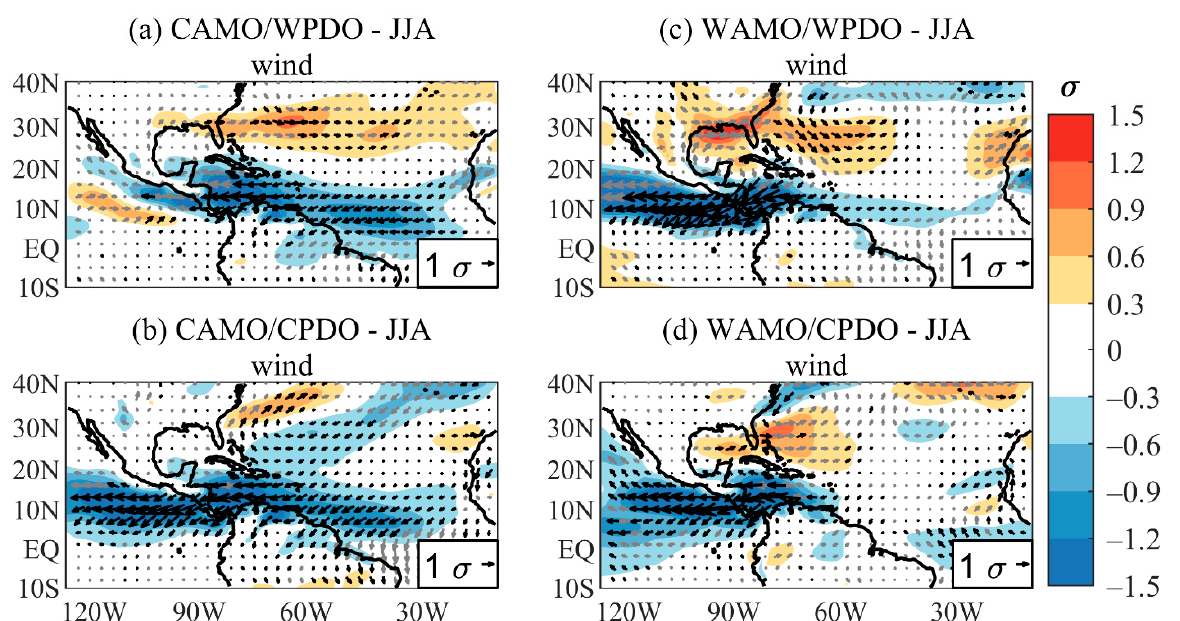
Figure 8. June–August standardized wind anomalies at 925hPa during intense CLLJ events of the: ( a ) CAMO/WPDO; ( b ) CAMO/CPDO; ( c ) WAMO/WPDO; and ( d ) WAMO/CPDO mean states. Shades interval is every 0.3 SDs. Display is same as Figure 5.